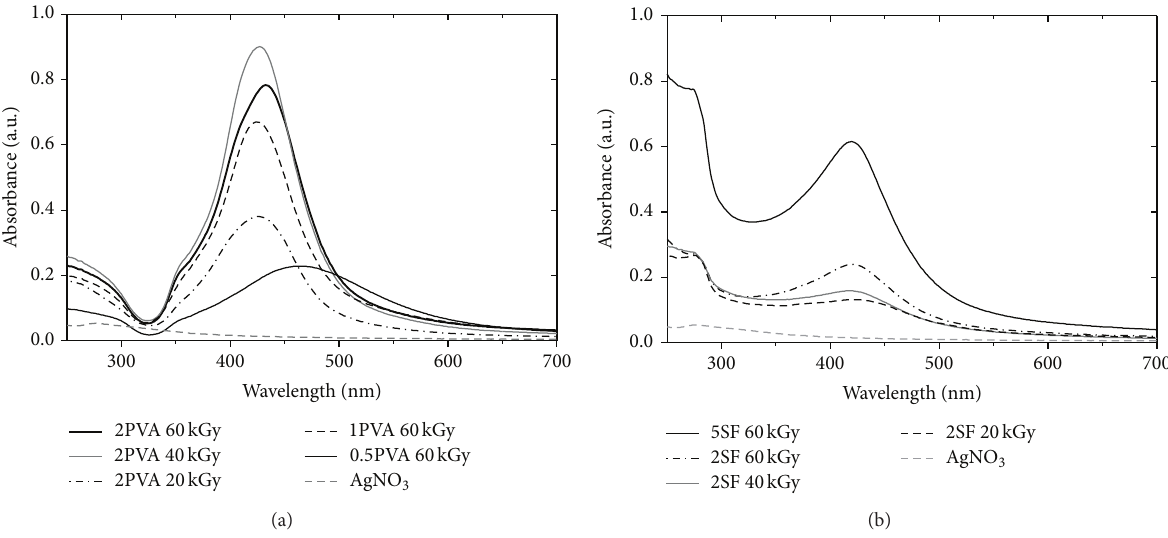
Figure 1: UV-Vis spectra of colloidal AgNPs synthesized by gamma radiolysis with (a) PVA or (b) SF as stabilizers at different irradiation doses and stabilizer concentrations.